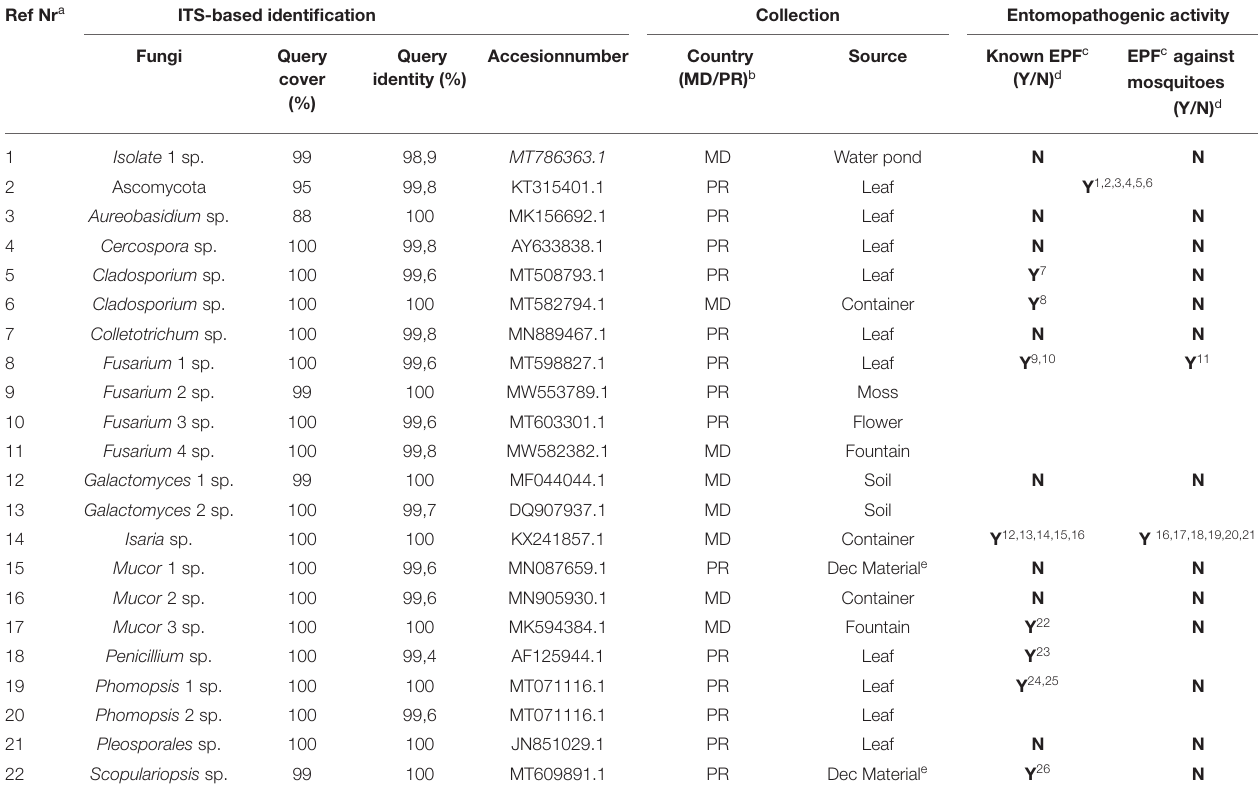
TABLE 1 | Collection and identification of